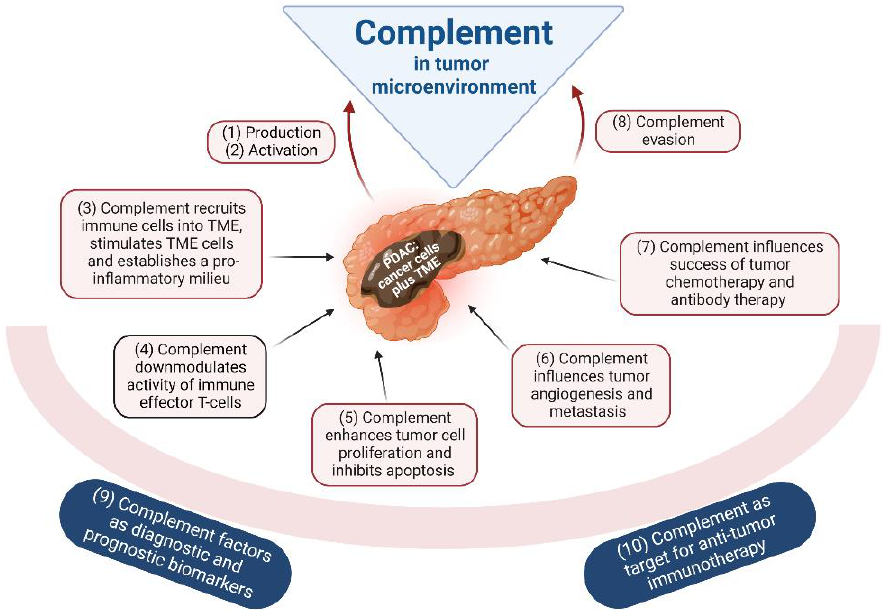
Figure 2. Putative encroachments of the complement system in the process of tumorigenesis, and, vice versa, putative interventions of tumors on complement in the TME (tumor microenvironment). Furthermore, putative applications of complement as PDAC biomarkers or in therapy are indicated. Numbering refers to the description in Section 5 of the text. Figure created with BioRender.com.